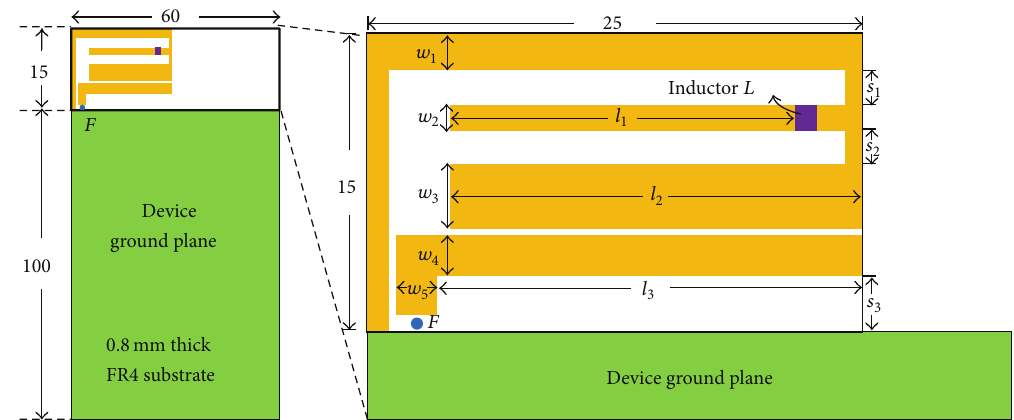
Figure 6: The benchmarking configuration of the internal antenna for LTE handheld devices.